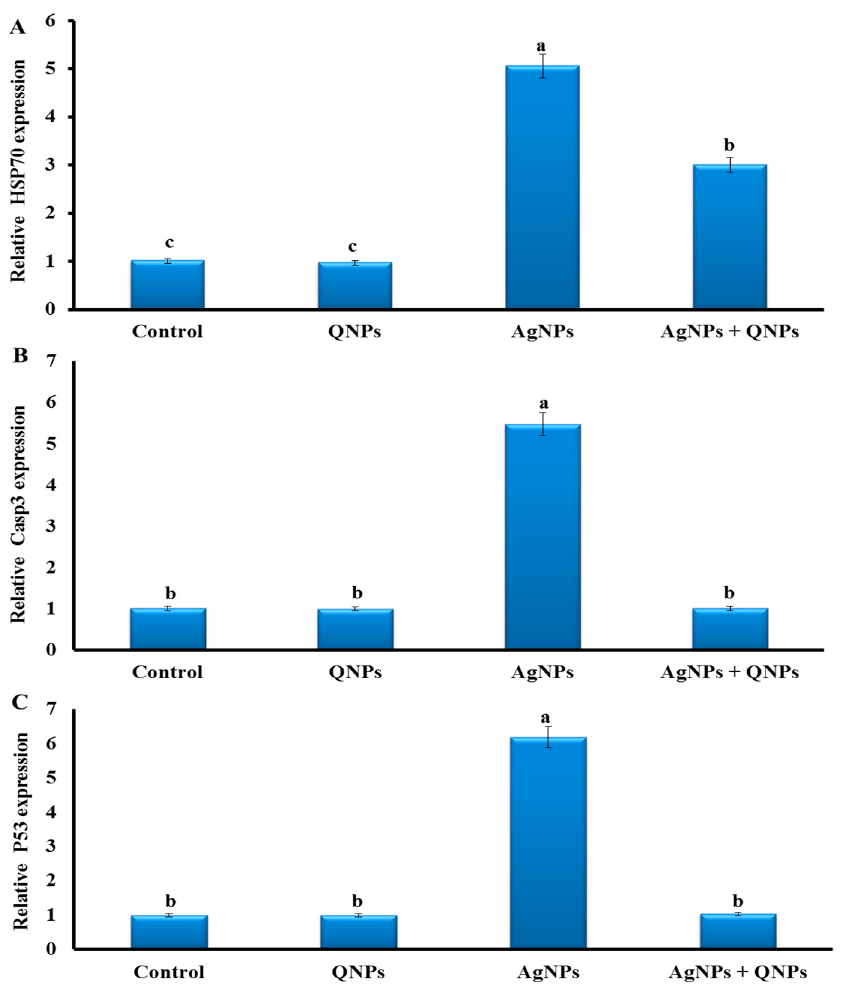
Figure 3. Expression of the stress-related genes ( A ) Hsp70 , ( B ) casp3 , and ( C ) p53 in the livers of the studied groups: Control group (basal diet), QNPs group (QNPs at a concentration of 400 mg kg − 1 diet), AgNP group (AgNPs at a level of 1.98 mg L − 1 ), and AgNP + QNP group (QNPs and AgNPs). Data were normalized using the reference gene β -actin . Values are presented as mean ± SEM. Values with a common superscript letter (a, b, c) significantly differ ( p < 0.05).